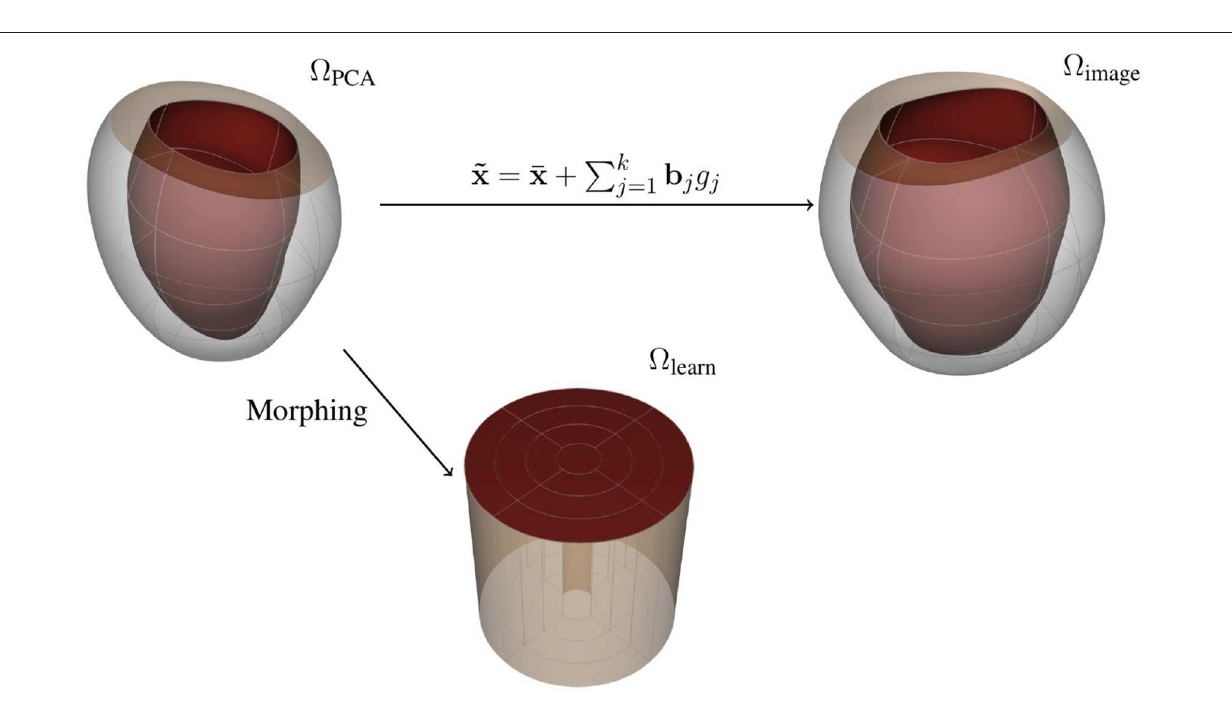
FIGURE 3 | Representations for the free-load LV: (top left) reference domain, (top right) image domain, and (bottom) learning